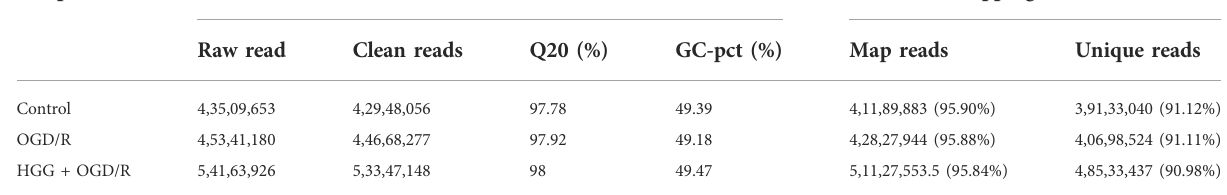
TABLE 2 Statistical summary analysis of transcriptional sequencing data of